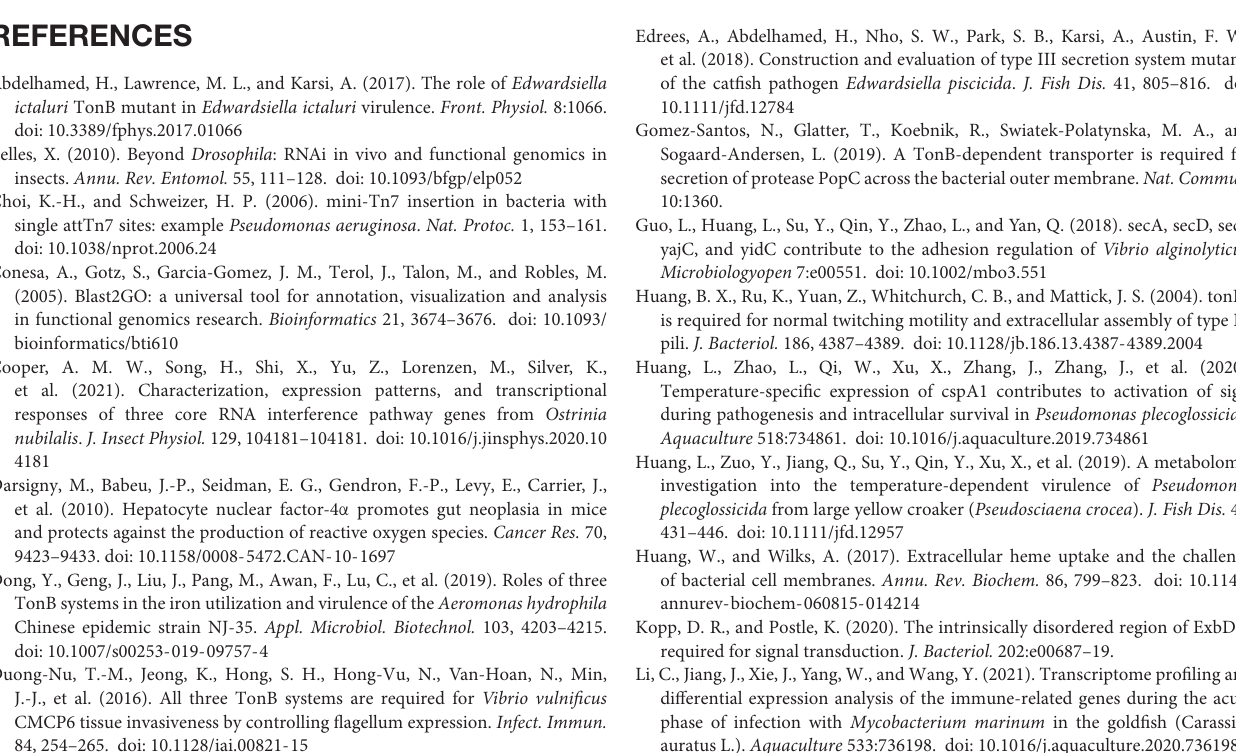
Supplementary Figure 1 | Verification of transcriptome data with qRT-PCR. Supplementary Figure 2 | Bases content along raw reads. Supplementary Figure 3 | Mean errors distribution along raw reads. Supplementary Figure 4 | Correlation of transcriptional data. Supplementary Table 1 | The sequences of four shRNAs for tonB gene. Supplementary Table 2 | The sequence of Primers for PCR and